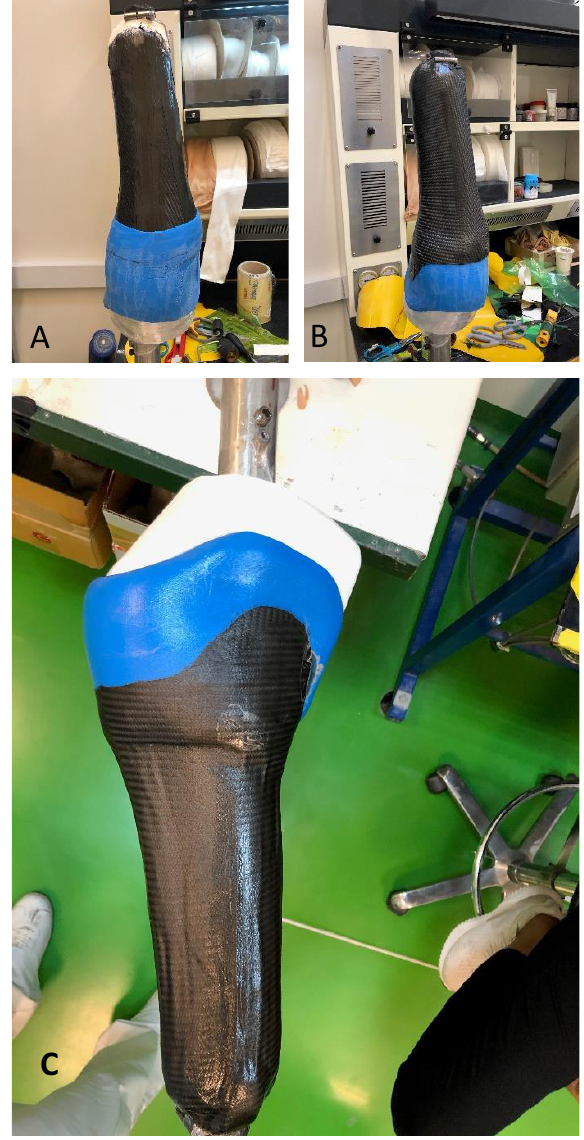
Figure 3: Images illustrating the (a) proximal brim over the first layer of prepreg carbon fiber, (b) trimmed version with second layer of prepreg carbon fiber applied and (c) final socket after curing.